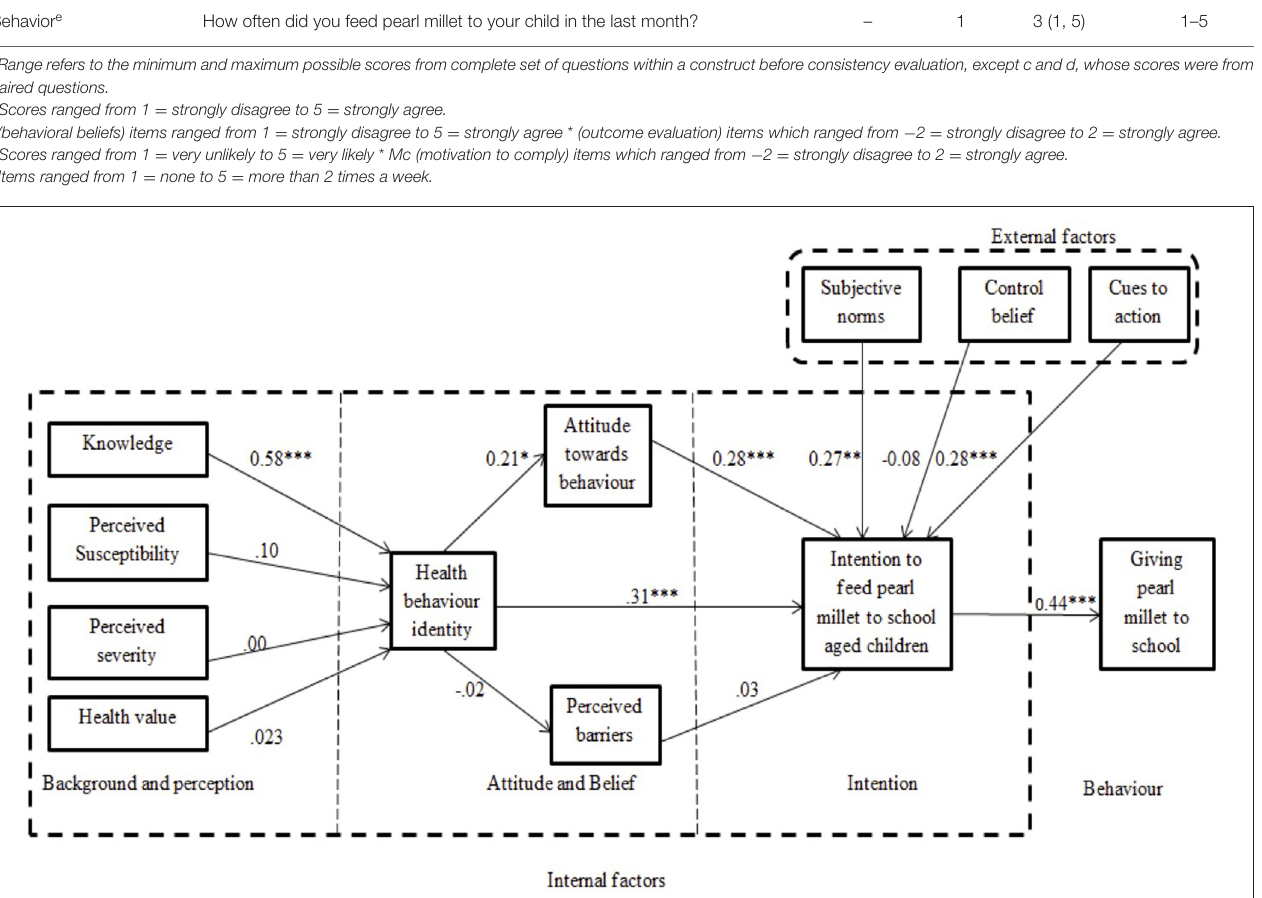
behavior identity. The control variables included were age of child, interviewer effect and caregivers’ education. Knowledge was a significant predictor of health behavior identity ( β